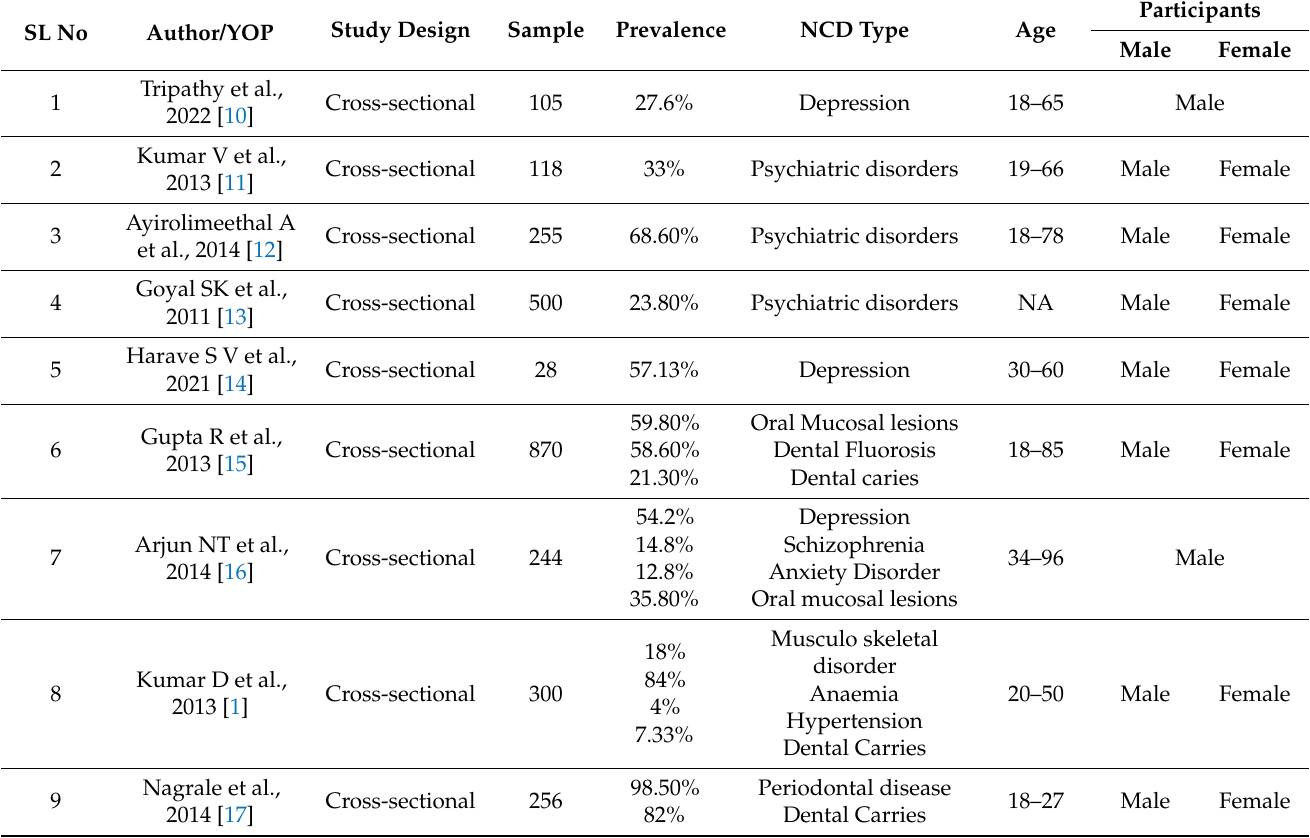
Table 1. Baseline characteristics of studies examining NCD among Prisons in India (N =